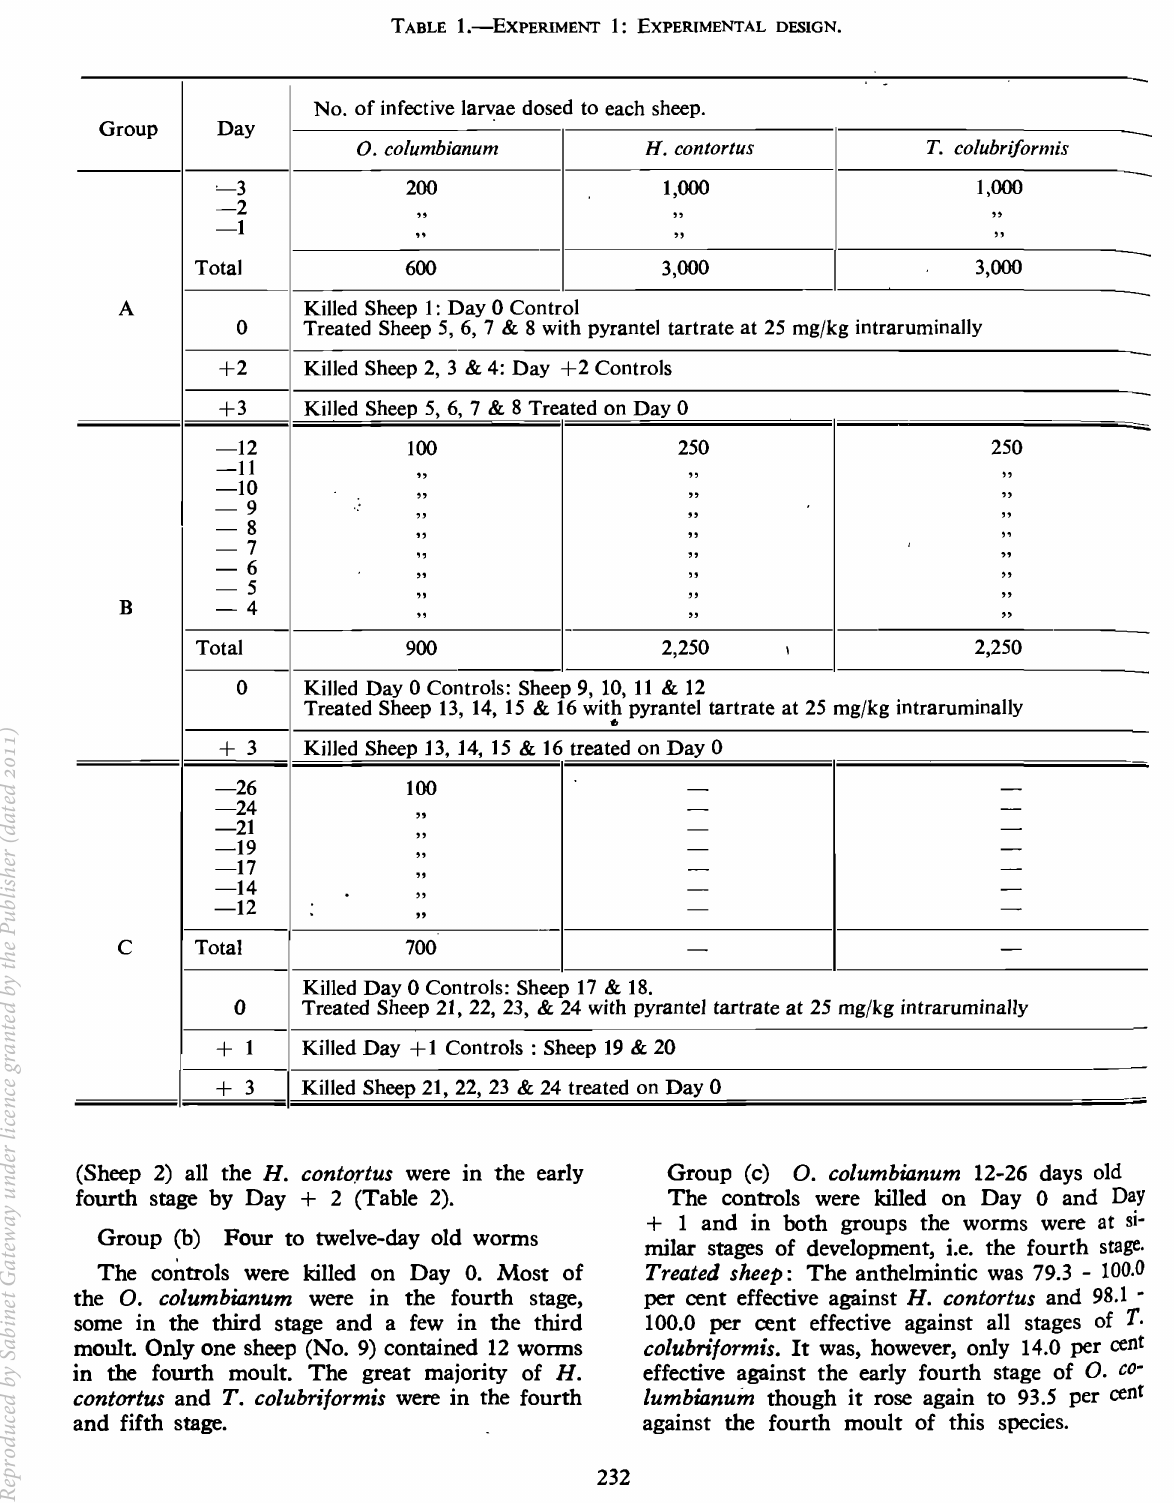
TABLE I.-EXPERIMENT 1: EXPERIMENTAL DESIGN.